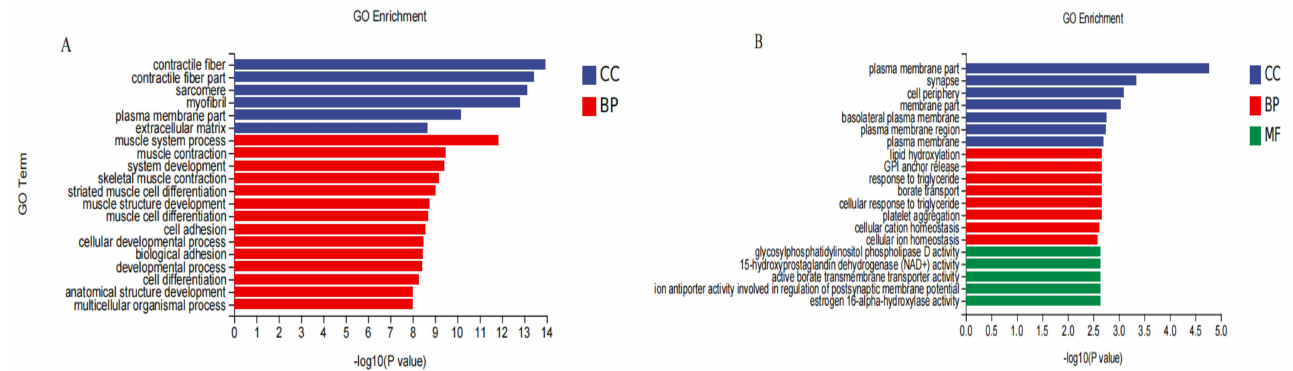
Figure 8. Gene ontology (GO) functional annotation and classification of differentially expressed genes (DEGs). ( A ) GO functional classification (Ad-DGAT2). ( B ) GO functional classification (sh- DGAT2). CC (cellular compound), BP (biological process), MF (molecular